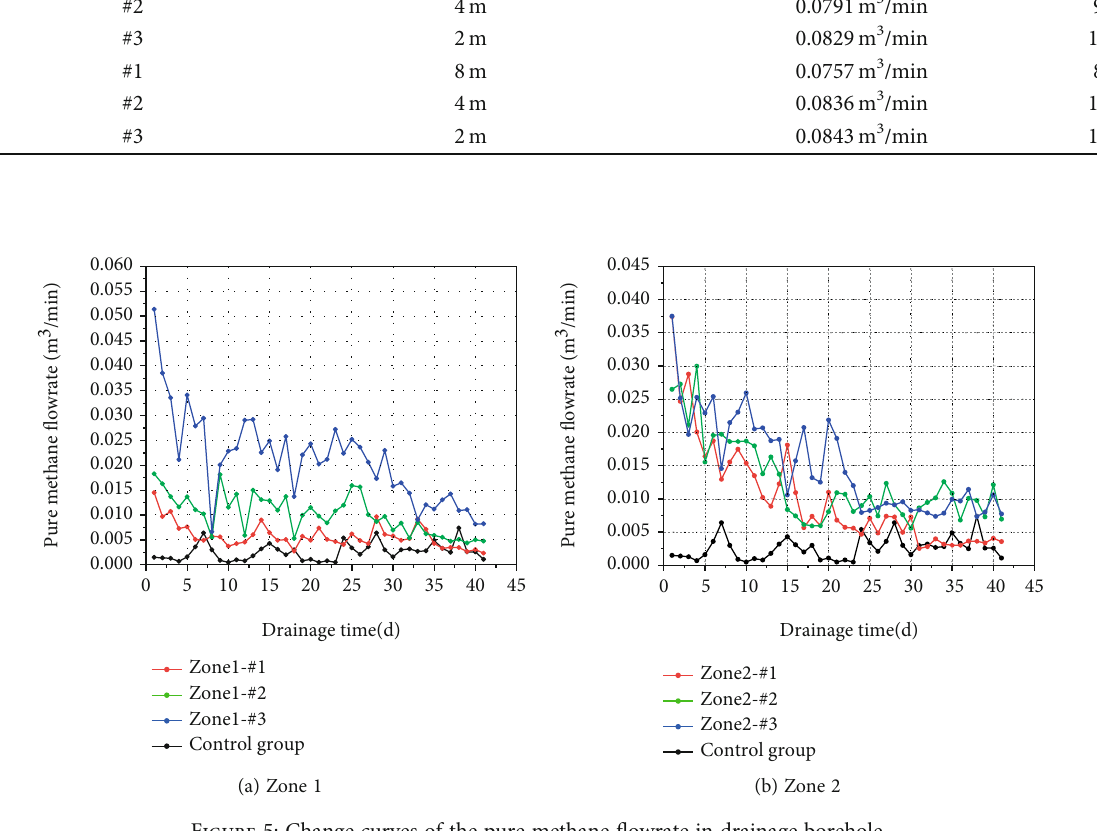
Figure 5: Change curves of the pure methane fl owrate in drainage